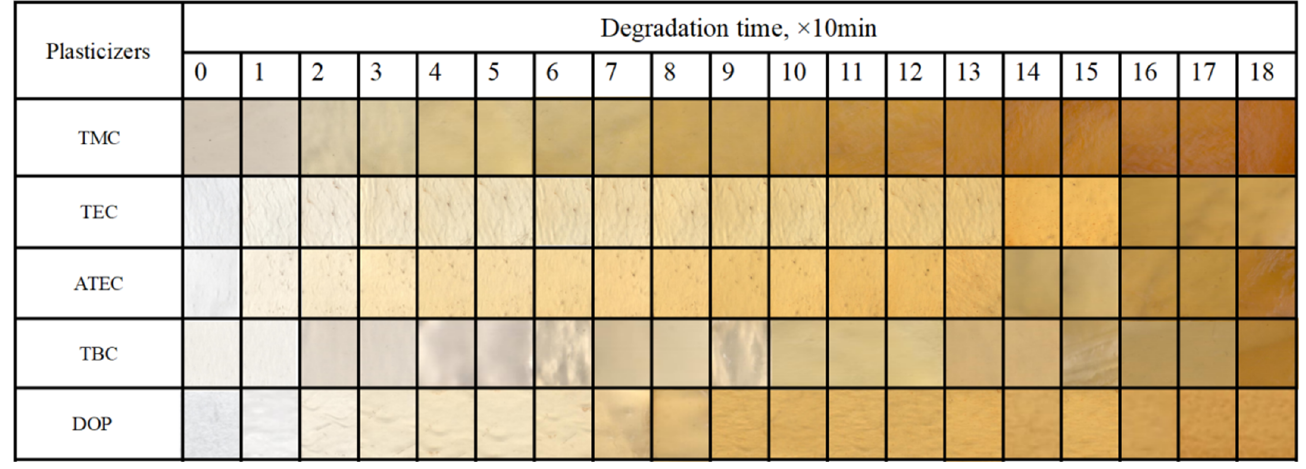
Figure 3. The thermal stability of PVC with 2 phr Zn(Arg) 2 and 30phr plasticizer at 180 °C in air. For proving different effect of citric acid esters on the thermal stability of PVC stabilized by Zn(Arg) 2 has related to the compatibility between plasticizer with Zn(Arg) 2 or PVC, the transmittance and haze of the PVC samples were tested and displayed in Figure 4. It can be seen from the results that the PVC samples containing DOP, TEC, ATEC, and TBC have better transmittance and lower haze than that containing TMC. The transmittance is higher than 75% in the range of 400 nm to 800 nm. The PVC plasticized by ATEC and TBC have highest transmittance, reached 94% in the range of 500 nm to 800 nm. The haze of them is also lower than others, less than 15%. The transparency of the PVC sam- ples indicate ATEC and TBC could disperse Zn(Arg) 2 more homogeneous in PVC, or they have the better compatibility with PVC. At the same time, PVC with TMC showed the lowest transmittance and highest haze, and the transparency of PVC with TEC is between that of PVC with TBC and TMC. The results tell us that the long carbon train in plasticizer is benefit for improving the transparency of PVC stabilized with Zn(Arg) 2 , like the thermal stability showed in Figure 3. Figure 4. The transmittance and haze of PVC with 2 phr Zn(Arg) 2 plasticized by citric acid esters and DOP.